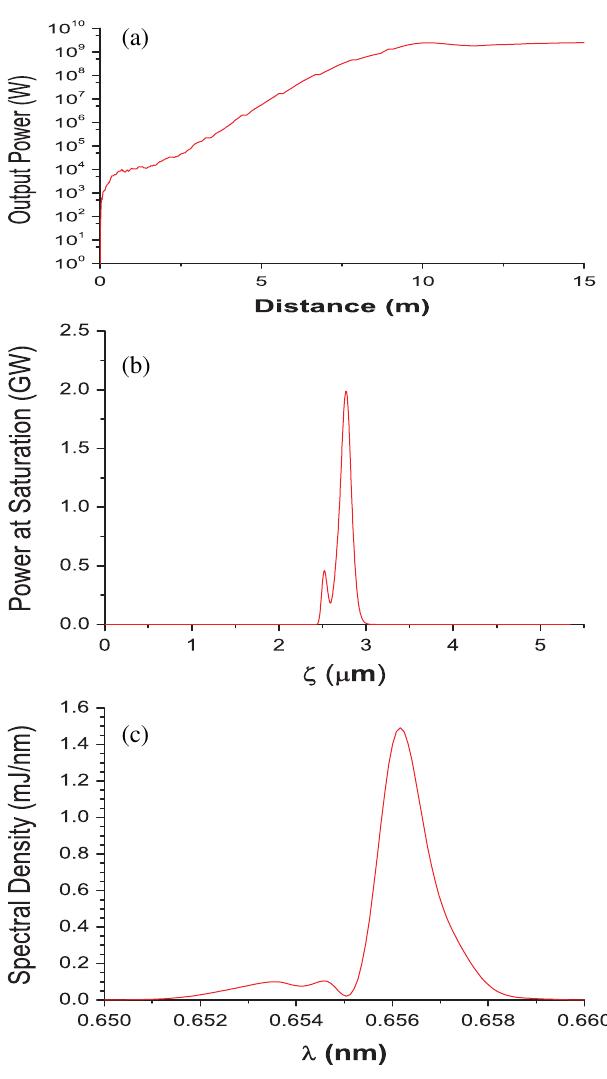
FIG. 5. (Color) GENESIS simulation results for the SPARX ultra- short low-charge case. Part (a) shows the exponential high gain regime saturating at 10 m of undulator, the regions of zero gain are due to the significant gaps between undulators reserved for the strong focusing quadrupoles and diagnostics. Part (b) shows the gain as a function of distance along the beam, the knee in the charge profile (Fig. 4) creates a similar knee in the radiation longitudinal profile. Part (c) shows the spectrum of the output radiation. The radiation has extremely narrow